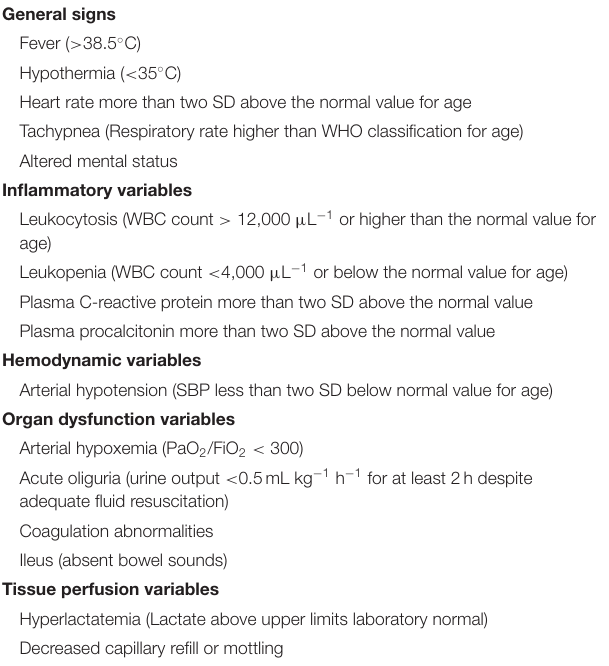
TABLE 2 | General variables and definitions of severe